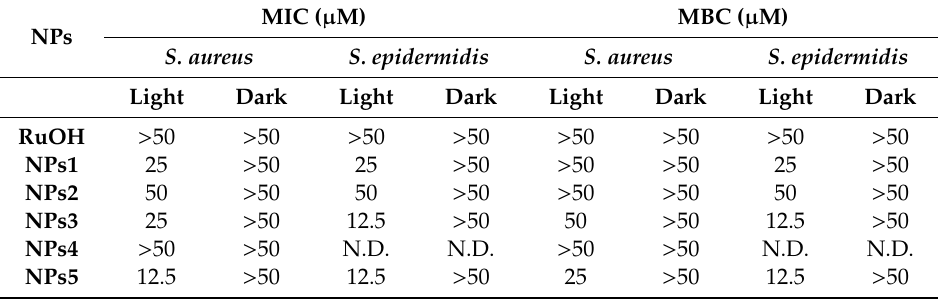
Table 2. Minimum inhibitory concentration (MIC) and minimum bactericidal concentration (MBC) ( µ M) for RuOH and NPs against S. aureus and S. epidermidis . MIC ( µ M) MBC ( µ NPs